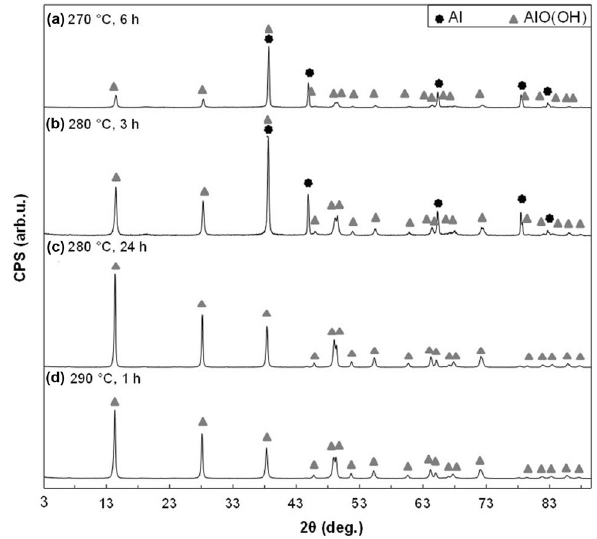
Fig. 4 XRD profiles for solid products from reactions using alu- minum powder at ( a ) 270 °C for 6 h, ( b ) 280 °C for 3 h, ( c ) 280 °C for 24 h, and ( d ) 290 °C for 1